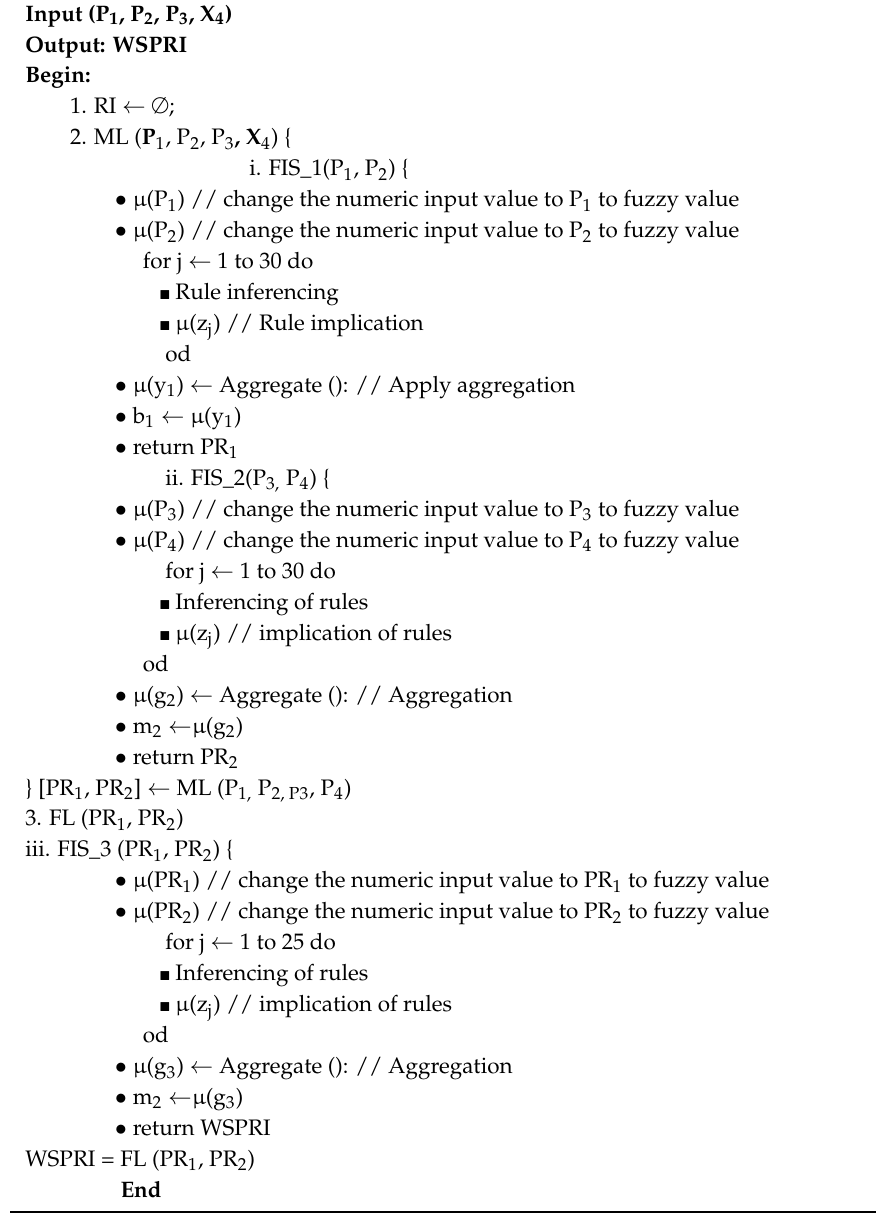
Algorithm_1: Pseudo code for a cohesive hierarchical fuzzy inference